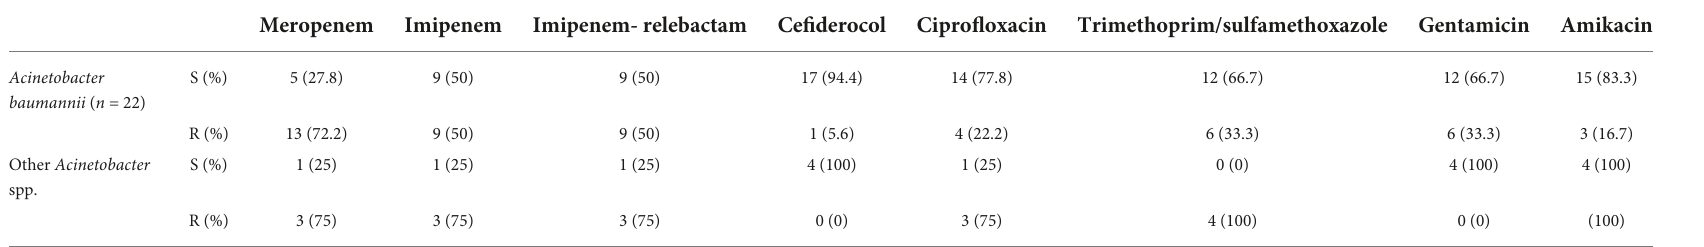
TABLE 2B Antimicrobial susceptibility pattern of carbapenem resistant Acinetobacter species isolated at JMC, Ethiopia. Bacterial species